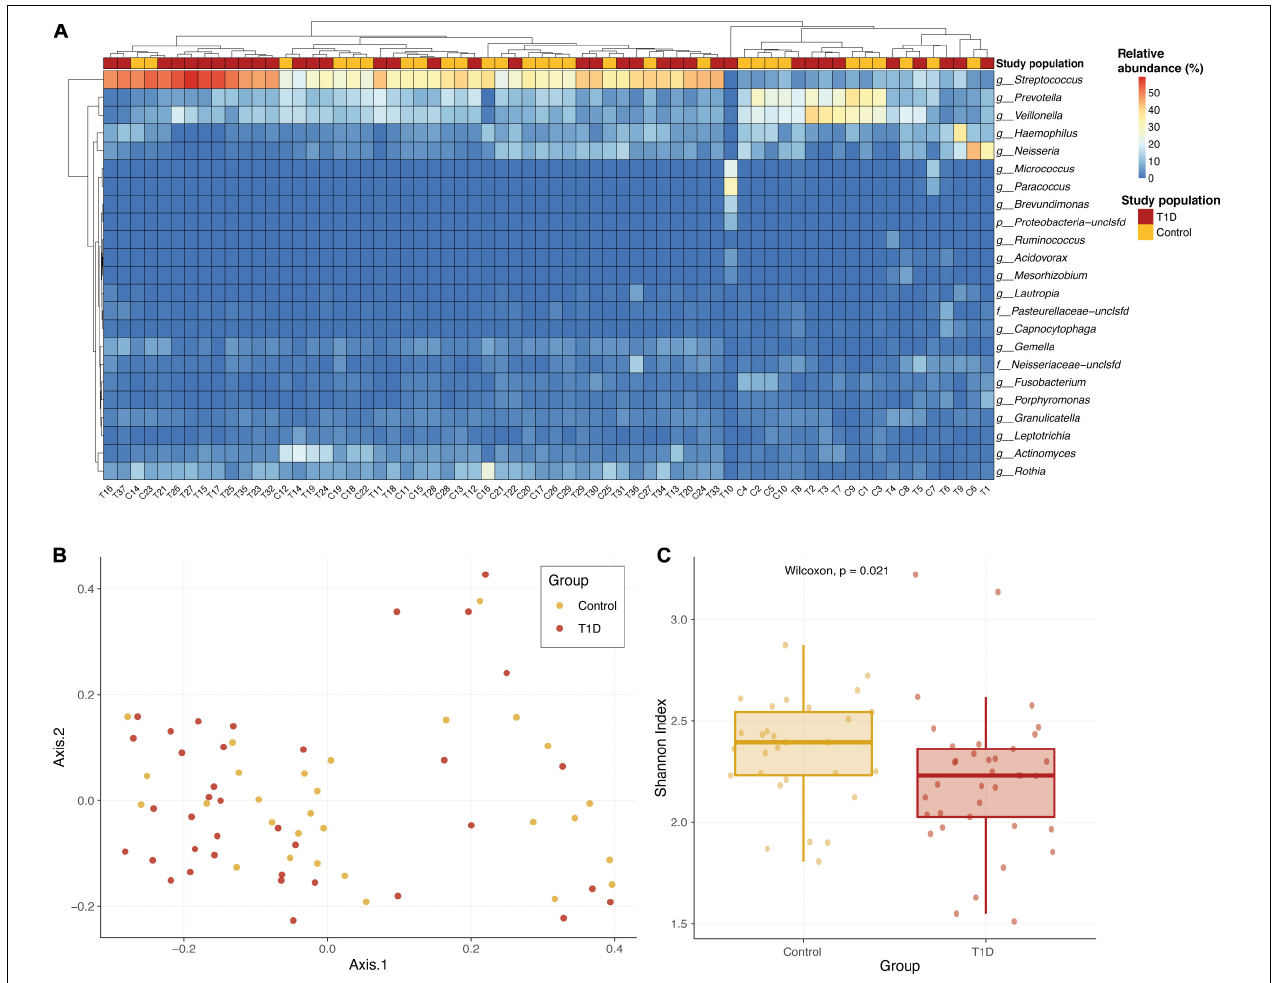
FIGURE 1 | Overall microbial composition in the two population groups. (A) Relative abundance of the most abundant genera in the saliva of T1D group (red) and the control group (yellow). The color of each cell in the heatmap is related to the abundance level of each genera per sample. (B) PCoA of the Bray–Curtis dissimilarity between study samples. Samples from T1D and controls are colored in red and yellow, respectively. Samples that are closer in their microbiome composition will be closer in this 2D plot. No clear distinction between the groups is identified. (C) Alpha diversity comparison of microbial communities of saliva samples from T1D group (red) and control group (yellow). Shannon diversity index was calculated as the metric for alpha diversity. The boxes represent the interquartile range (IQR) between the first and third quartiles (25th and 75th percentiles, respectively) and the vertical line inside the box defines the median. P -value calculated using Wilcoxon test.